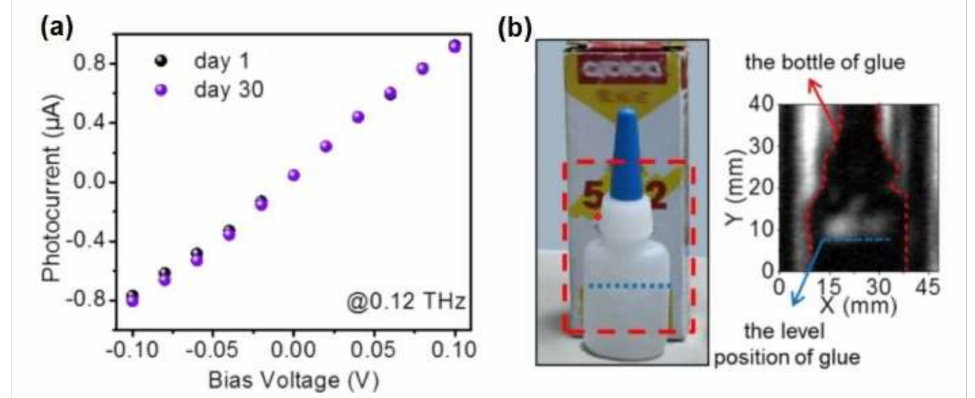
Figure 12. ( a ) Aging in air of SnSe 2 -based short channel photodetector, black and purple spot represent the photocurrent of as-prepared device and after 30 days in air, respectively. ( b ) The THz imaging of a glue-jar in the box at 0.12 THz. Reproduced with permission from